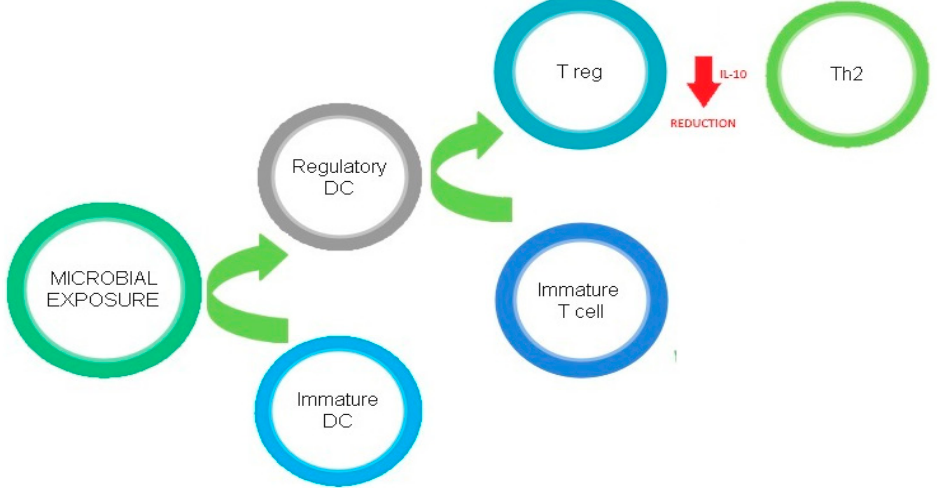
Figure 1. Regulatory effects of microbial exposure on Th2 cells.